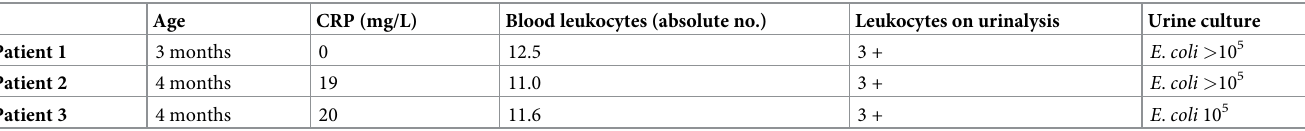
Table 2. Included patients with urinary tract infection.